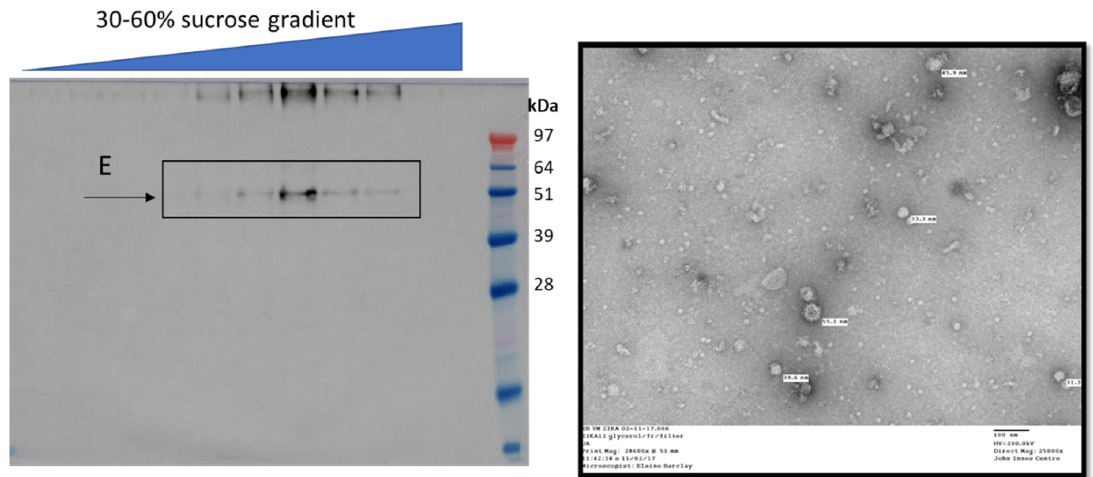
Figure 4. ZIKV prM-E expression in plants yields possible VLPs. The prM-E region of ZIKV was transiently expressed in N. benthamiana and purified on a sucrose cushion followed by desalting and concentration on a spin filter concentrator. The concentrate was then further purified over a 30–60% ( w / v ) sucrose gradient and the fractions were assayed by anti-E Western blot (left). The positive fractions (indicated) were pooled, buffer-exchanged and concentrated on a spin filter concentrator and imaged by transmission electron microscopy (right), revealing possible VLPs 35–55 nm in size. Samples stained with 2% ( w / v ) uranyl acetate, scale bar is 100 nm.